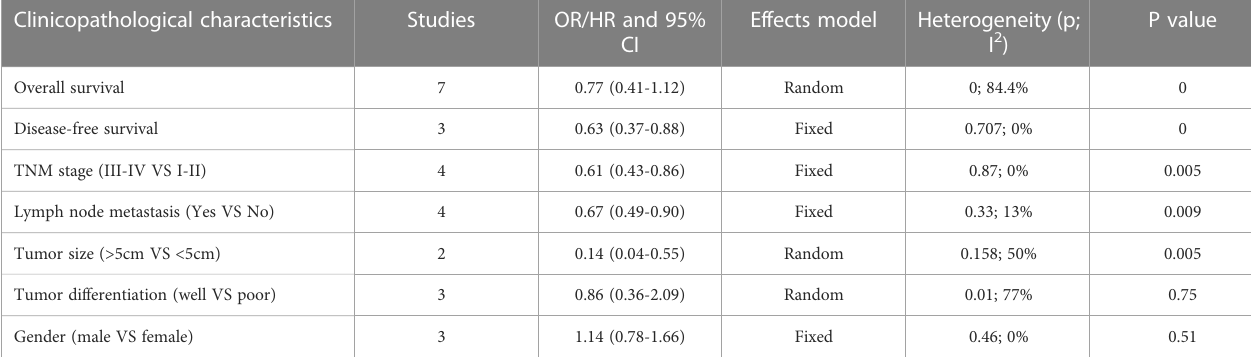
TABLE 3 Relationship between ING3 expression and clinicopathological